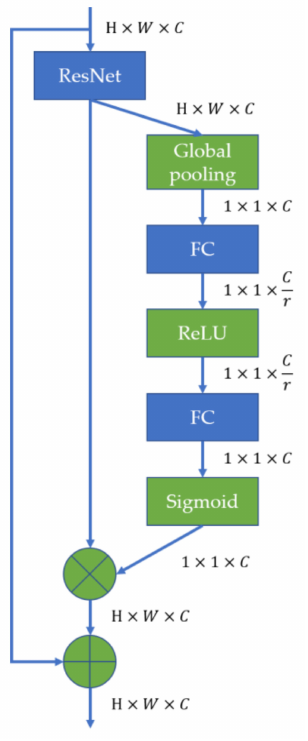
Figure 2. The structure of the SE block inserted into the